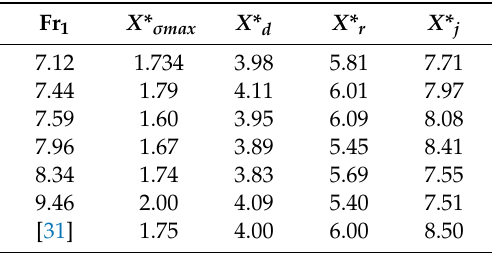
Table 3. Approximate positions of the characteristic points.